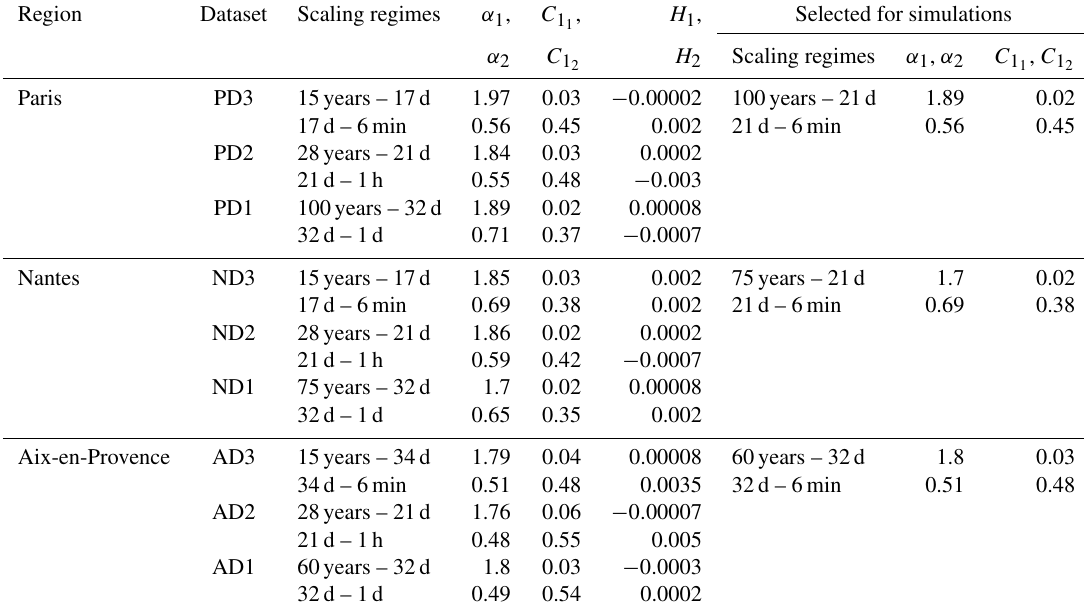
Table 4. UM parameter estimates for the first and second scaling regimes from different datasets (PD1 to AD3) and the scaling regimes and parameters selected for simulating rainfall over each corresponding region. H values are not included in the selected parameters and are assumed to be zero since these rain time series seem to be almost conservative (both H 1 and H 2 are close to zero). Region